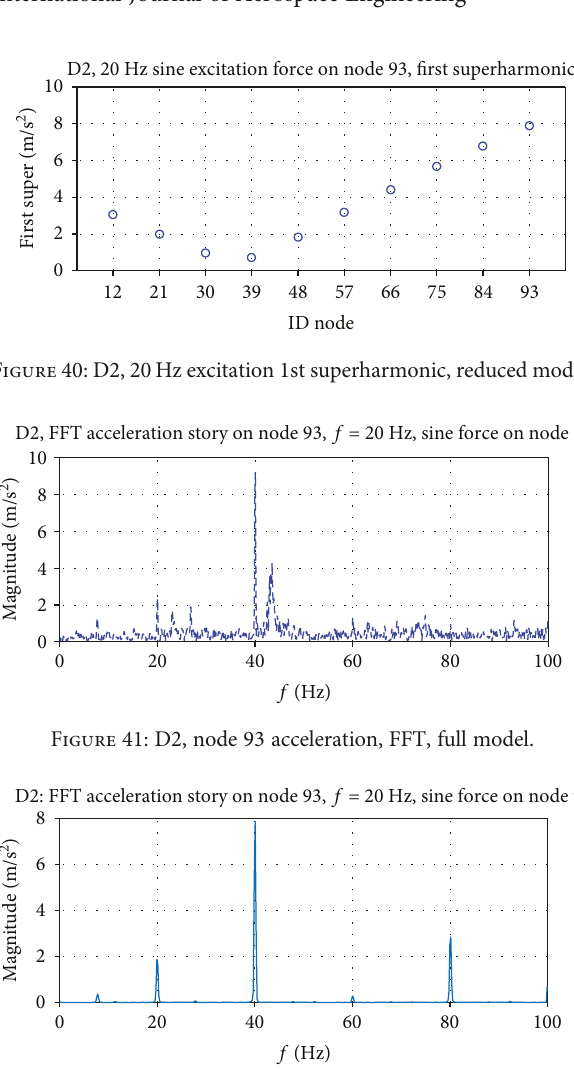
Figure 42: D2, node 93 acceleration, FFT, reduced model.